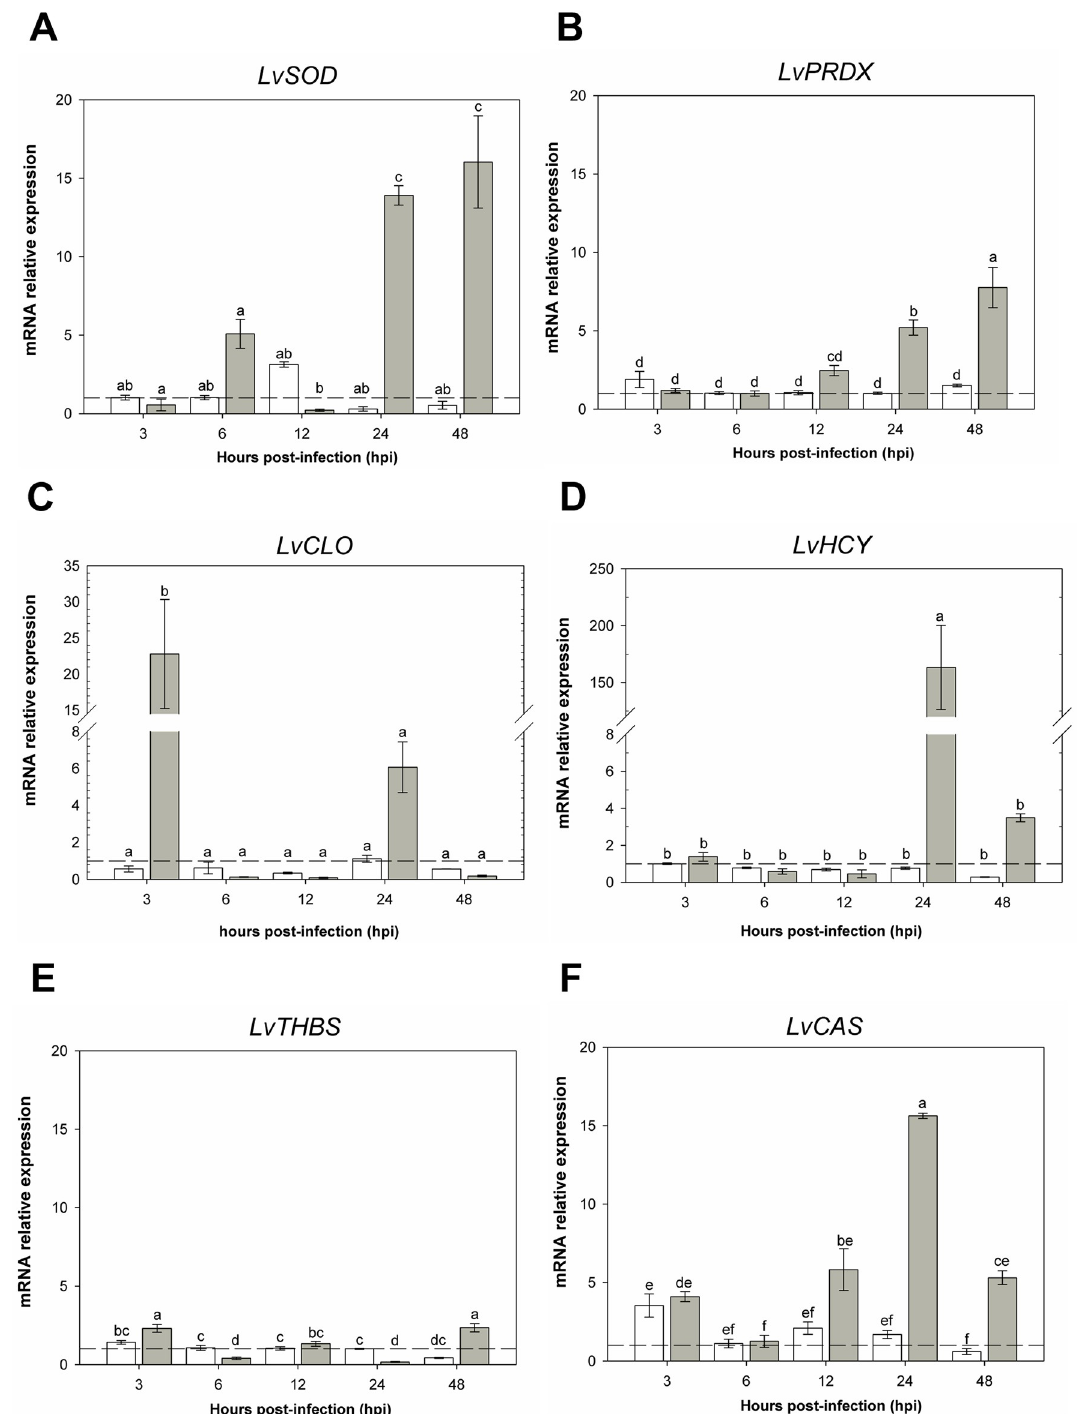
Fig 8. mRNA expression of immune system- related genes. RT-qPCR results showing the relative mRNA expression of DETs. For all the charts, the X-axis shows different time point post-infection (shown as hpi), the Y-axis shows relative mRNA expression (target gene/ LvRPL7 ); bars show the mean and error lines the standard error (n = 9). Dash line represents the normalized value and lower case letter(s) show statistically significant differences (p < 0.05). A) Cytosolic superoxide dismutase. B) Peroxiredoxin. C) Cottable Protein. D) Hemocyanin. E) Thrombospondin. F) Cellular apoptosis susceptibility protein.